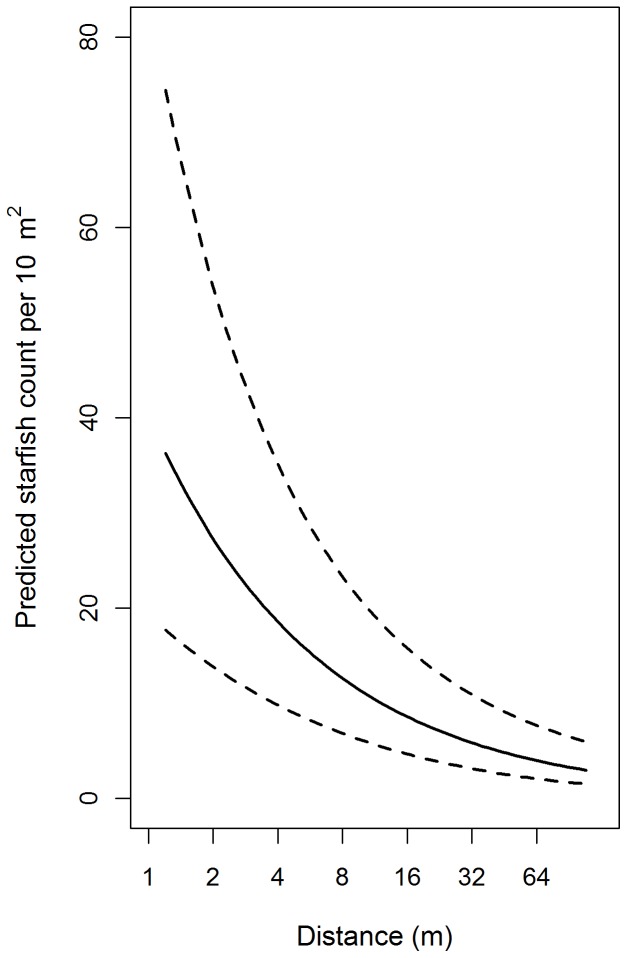
Mixed model predicted (solid line) numbers of starfish v. distance.Predictions are back-transformed. The dashed line represents the 95% confidence interval.